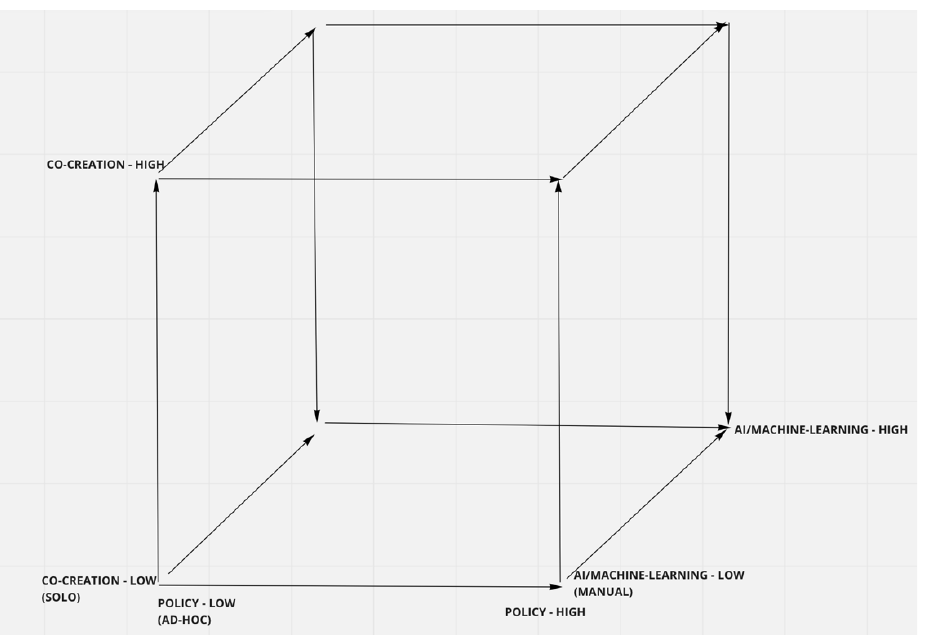
Figure 1 Organisation of the axes in the